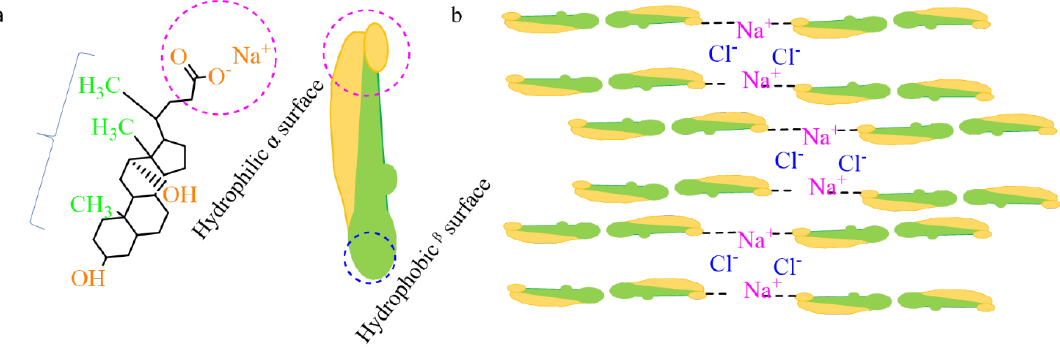
Figure2. Schematicrepresentationof( a )thesrructureofSodiumdeoxycholate(Na-DOC)and( b )Sodium Figure 2. Schematicrepresentation of ( a ) the srructure of Sodium deoxycholate(Na-DOC) and ( b ) deoxycholate hydrogel formation induced by Sodium deoxycholate hydrogel formation induced by NaCl.